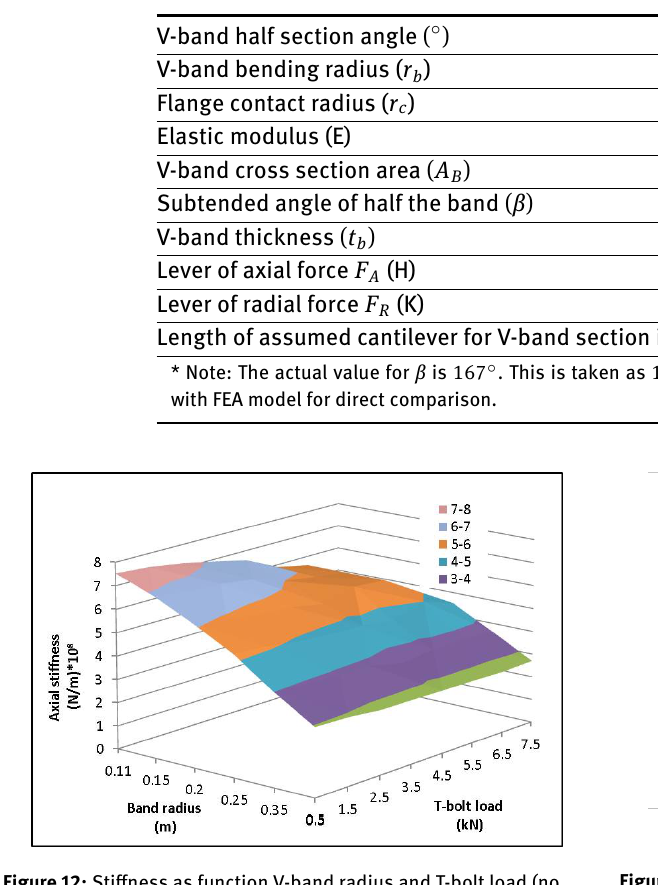
Figure 12: Stiffness as function V-band radius and T-bolt load (no friction, FEA).